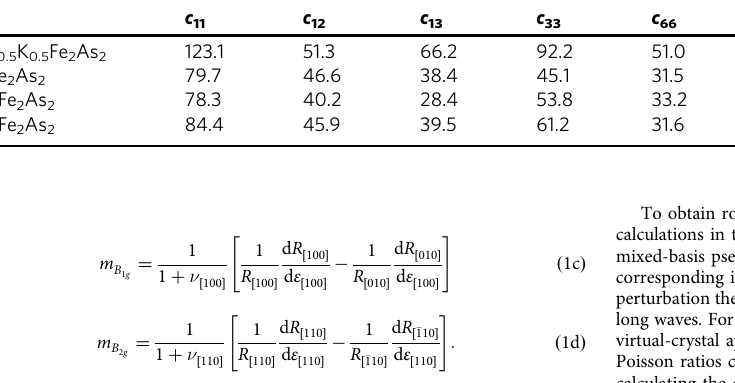
Table 1 Table of elastic constants (in units of GPa) and Poisson ratios (unitless), obtained from ab initio